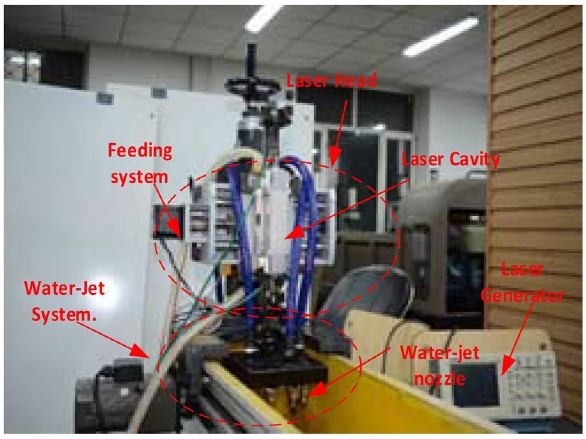
Fig. 8 Experimental set-up of WJG Nd: YAG laser wood